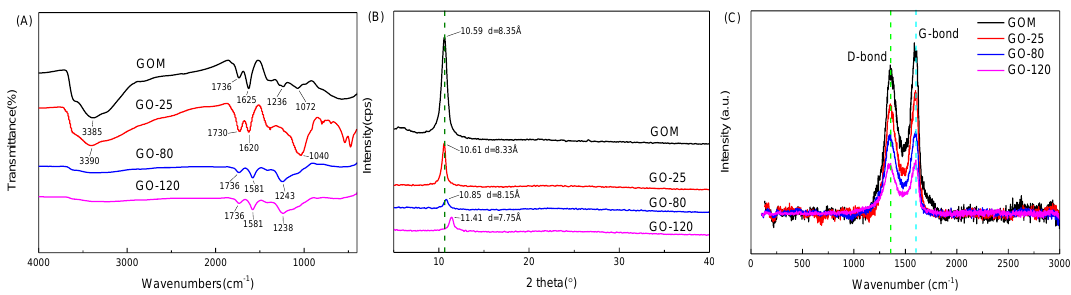
Figure 2. ( A ) FTIR spectra of GOM, GO-25, GO-80, GO-120, ( B ) XRD patterns of GOM, GO-25, GO-80, GO-120 and ( C ) Raman spectra of GOM, GO-25, GO-80, GO-120.